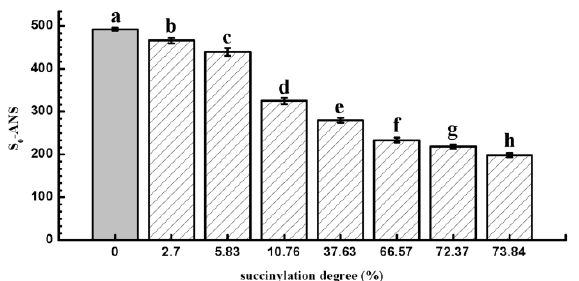
Figure 5. Changes in S 0 -ANS of EWP and SEWP (mean ± SD, n = 3). The different letters (a–h) above the columns indicate significant differences ( p < 0.05) among the samples treated according to different succinylation degrees.